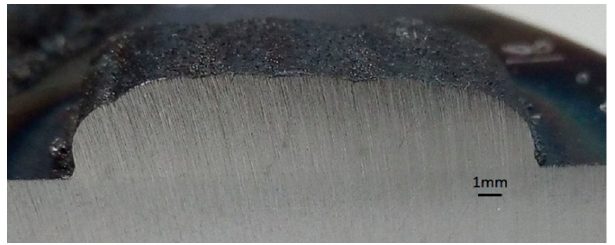
Figure 8. Macrograph of a cross section following the Zig Zag strategy.